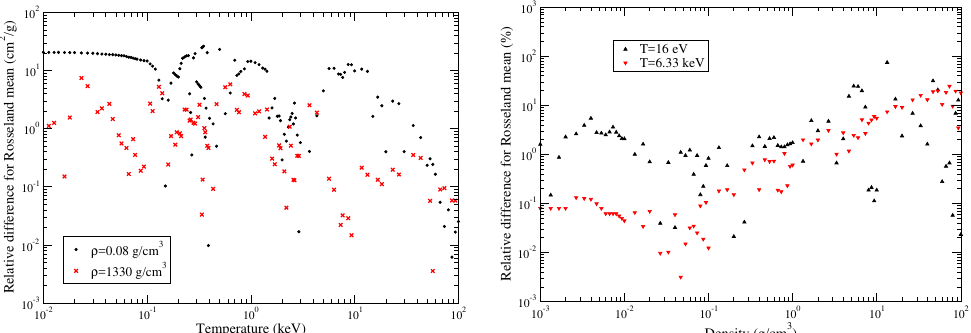
Figure 18. Left: comparison between the iron Rosseland mean opacity calculated on the dense grid (140 densities and 150 temperatures), and interpolated on it from a smaller grid for two different densities: ρ =0.08 g.cm − 3 and ρ =1330 g.cm − 3 (left) and two different temperatures: T =16 eV and T =6.33 keV (right). The latter isochores and isotherms were chosen because they yield the highest discrepancies.